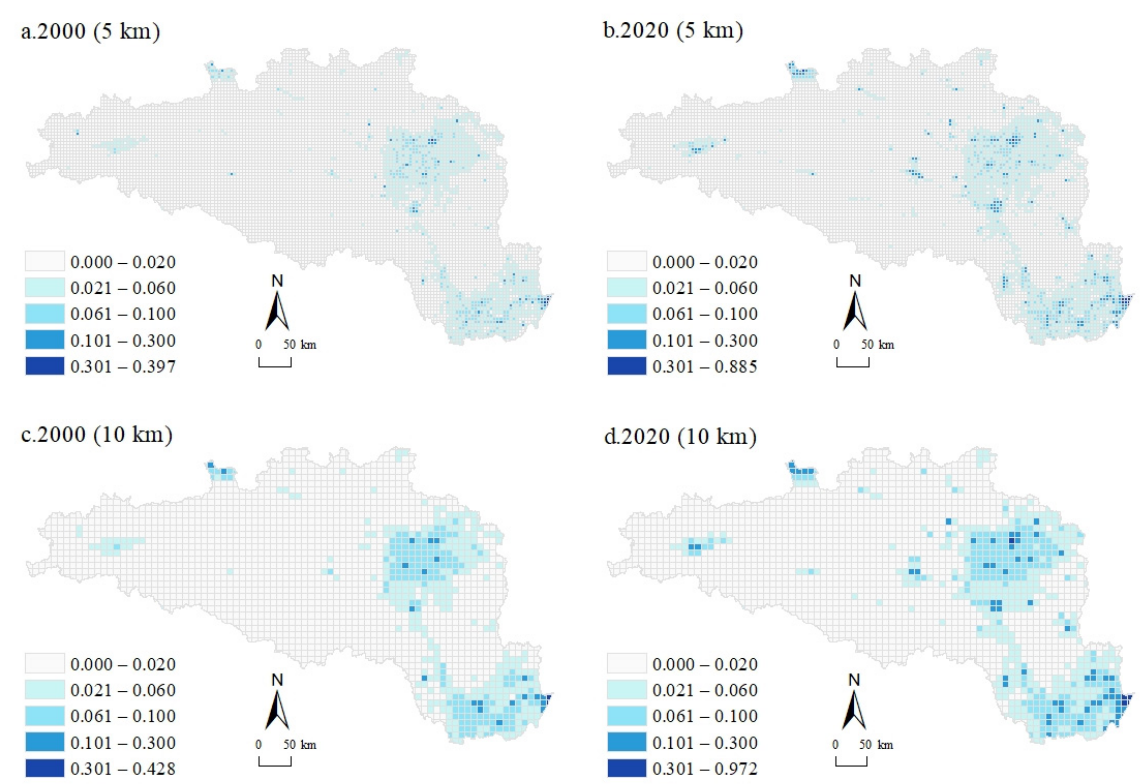
Figure 3. Spatiotemporal patterns of UL at 5 km and 10 km grid scales for 2000 and 2020 in the HREEB.